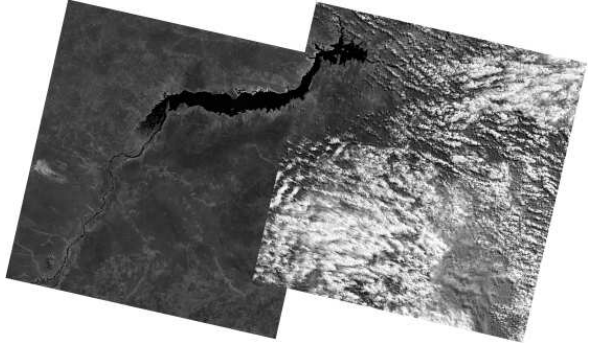
Figure 3: Mosaic of June 2015.